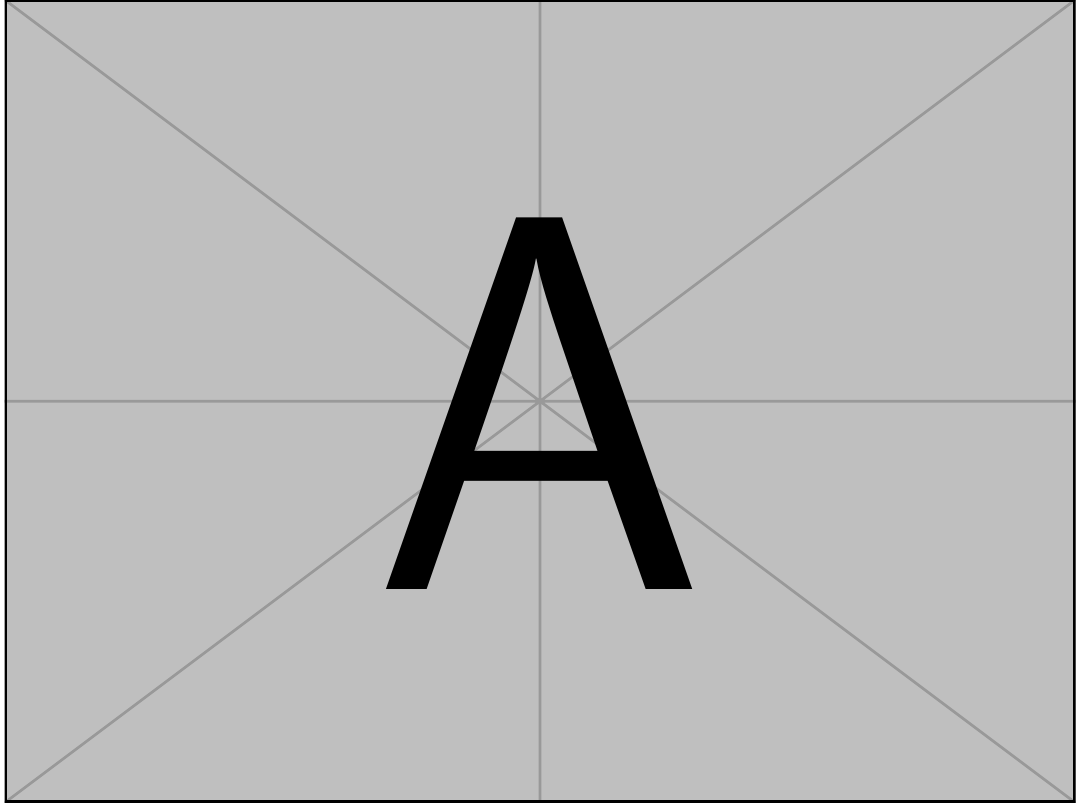
Figure 1. INSERT IFRAME HERE. Collected data on COVID-19 contact tracing applications. This table is interactive and may be updated as more applications are